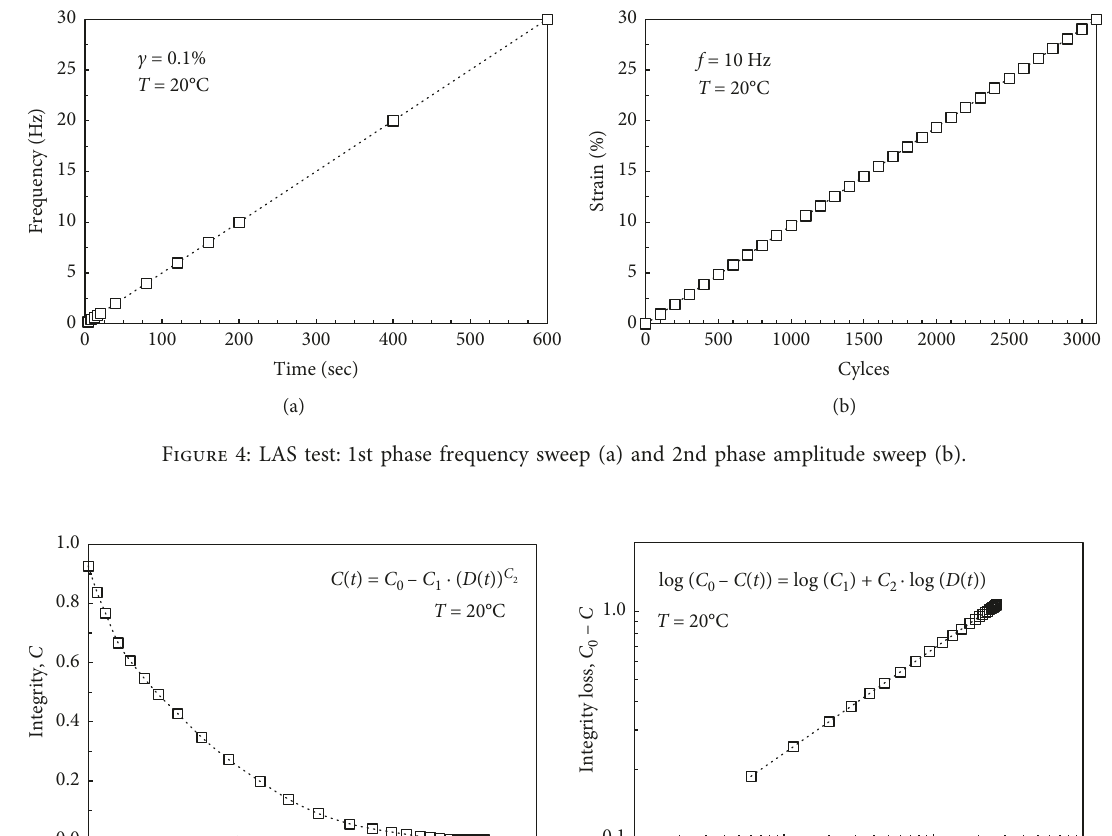
Figure 5: Typical LAS test results: integrity vs. damage (a); integrity loss vs. damage